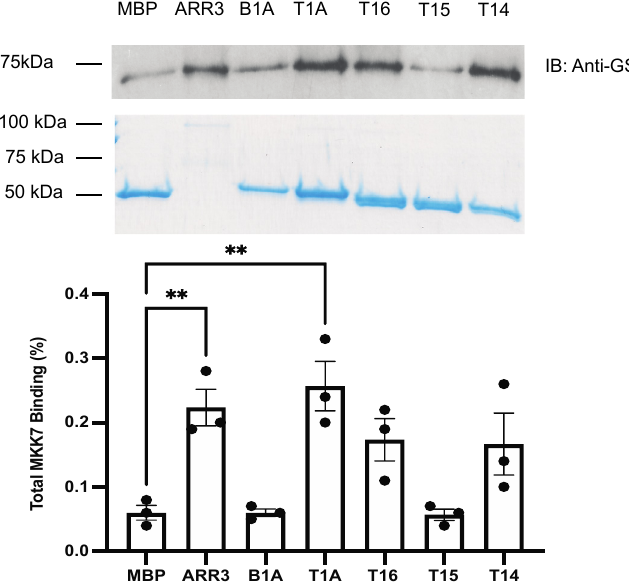
Figure 4. MBP pull-down of GST-MKK7. Purified MBP fusions of indicated peptides and full- length arrestin-3 (10 μ g) were immobilized on amylose resin and incubated with purified GST- MKK7 (5 μ g), as described in the methods. The beads were washed, and bound proteins were eluted with 50 mM maltose. Aliquots of eluates were subjected to SDS-PAGE. The loading of MBP con- structs was assessed by Coomassie staining (middle panel). MKK7 binding was measured by West- ern (top panel). Densitometric quantification (bottom panel) was performed using ImageJ software [26]. Dots represent measurements in individual experiments. Statistical analysis was performed